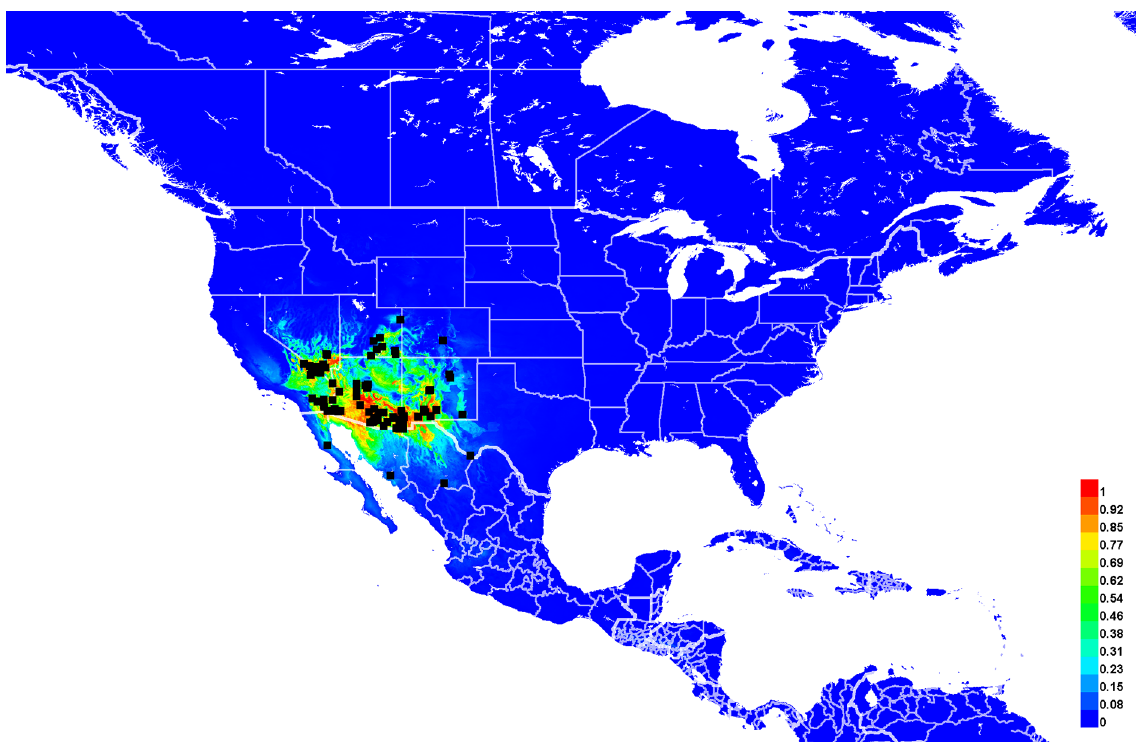
Fig. 57. Georeferenced collection records of Lasioglossum ( D. ) mesillense (Cockerell, 1898) (black squares) and predicted distribution by maximum entropy ecological niche modeling in Maxent (colour shading). Warmer colours indicate higher cloglog probability of